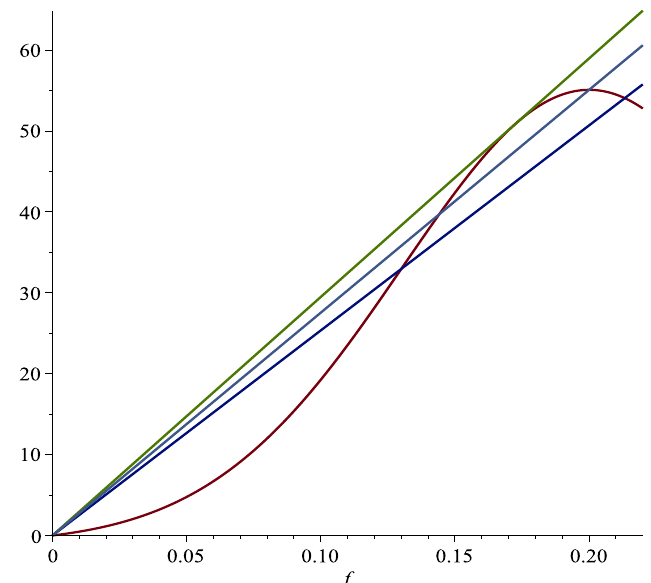
Figure 1. Return/risk ratios as slopes with the top line at the tangent, the middle line at the growth optimal, and the bottom line at the inflection point.